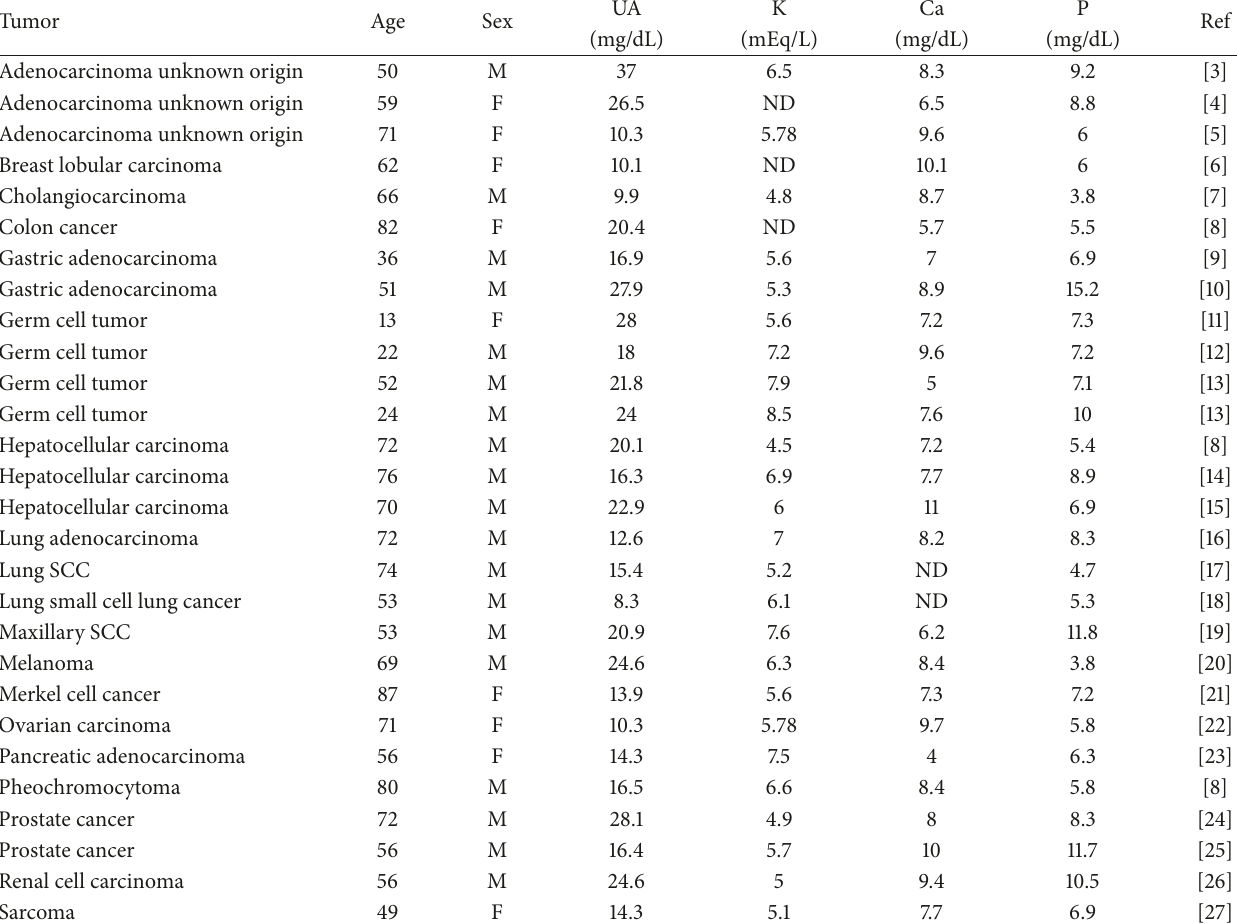
Table 2: Review of spontaneous TLS in patients with solid